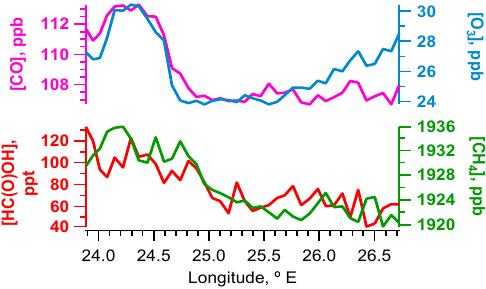
Figure 11. The concentration trend of HC(O)OH, CH 4 , O 3 and CO between the longitudes 23.8° E and 26.7° E along transect x , during flight B804 (19 September 2013), highlighting the variability within the flux between the initial longitudinal points of 23.8° E and 25.0° E.